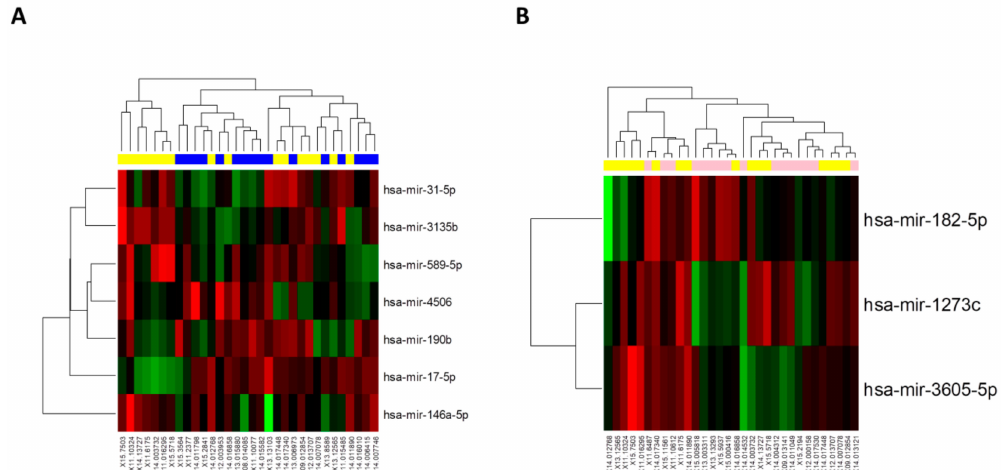
Figure 2. Hierarchical clustergram. Hierarchical clustergram discriminating miRNA expression in paired samples. Part A is based on 7 miRNAs comparing samples before rejection (shown in blue) and during rejection (shown in yellow). Part B is based on 3 miRNAs comparing samples during rejection (shown in yellow) and after rejection (shown in pink). All miRNAs were statistically significant and di ff erentially expressed ( p < 0.05). The gradient of green and red colours is used as the heatmap (green colour indicates lower expression whereas red colour indicates higher expression of individual miRNAs in analysed samples).